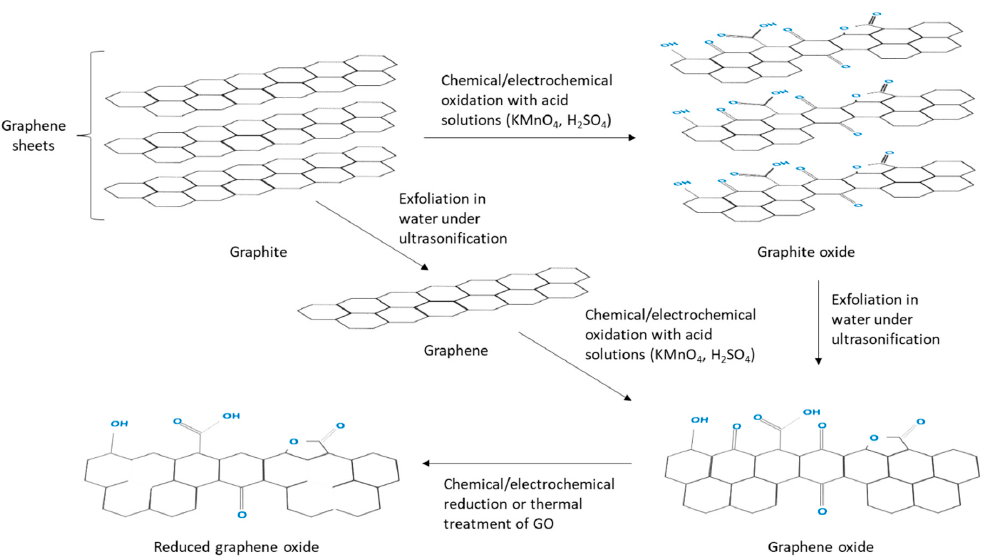
Figure 7. Preparation routes of graphene, GO and rGO carbon nanomaterials from graphite for application in EIs